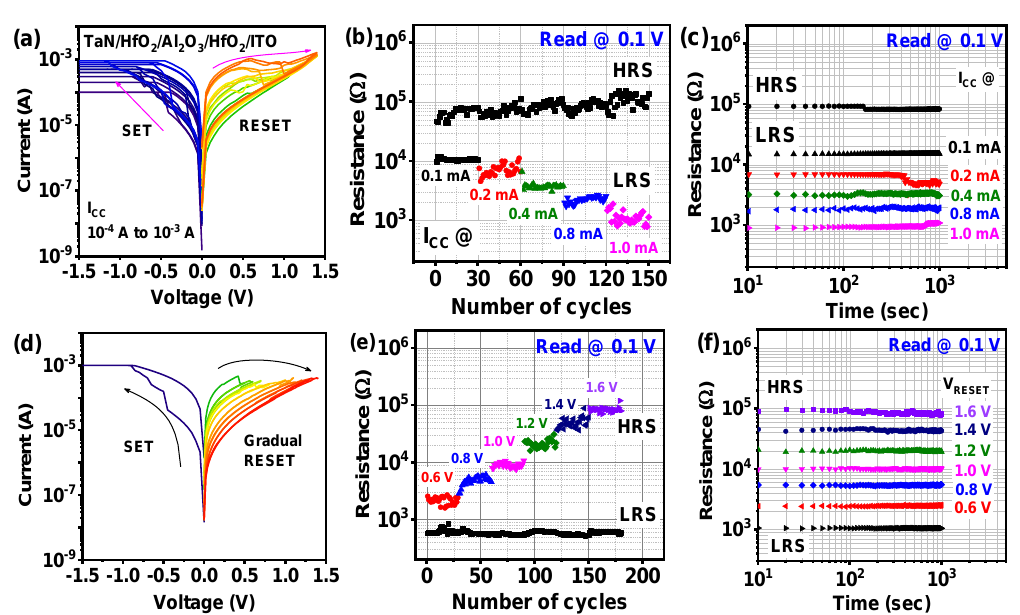
Figure 5. ( a ) Multilevel storage of tri-layer RRAM device under varying SET compliance currents from 100 µA to 1 mA; ( b ) reliability test for data endurance (30 cycles); ( c ) retention characteristics (10 3 s) with the corresponding increasing SET I cc ; ( d ) bipolar resistive switching with multilevel high resistance state under increasing RESET voltage for tri-layer memristor device; ( e ) multi-level endurance characteristics under different RESET voltages for 30 cycles each; ( f ) retention characteristics of LRS and multilevel HRS under different RESET V stop for 10 3 s.